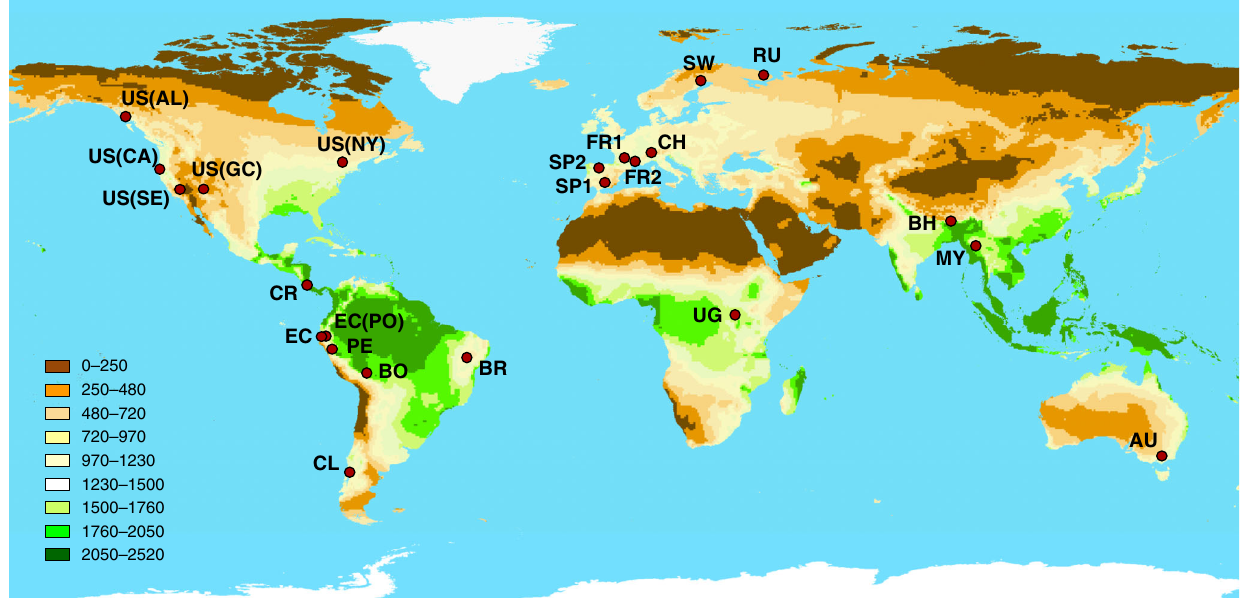
Fig. 1 Geographical distribution of the forest regions studied. The colour gradient (see legend) represents the climatological NPP (FAO ’ s NPP index expressed in gDM m 2 yr − 1 ). Legend for acronyms: US(AL) — Alaska (US), US(CA) — Northern California (US), US(NY) — New York State (US), US(SE) — Sequoia National Park (US), US(GC) — Great Canyon (US), CR (Costa Rica), EC — Ecuador dry forest, EC(PO) — Podocarpus National Park (Ecuador wet), PE